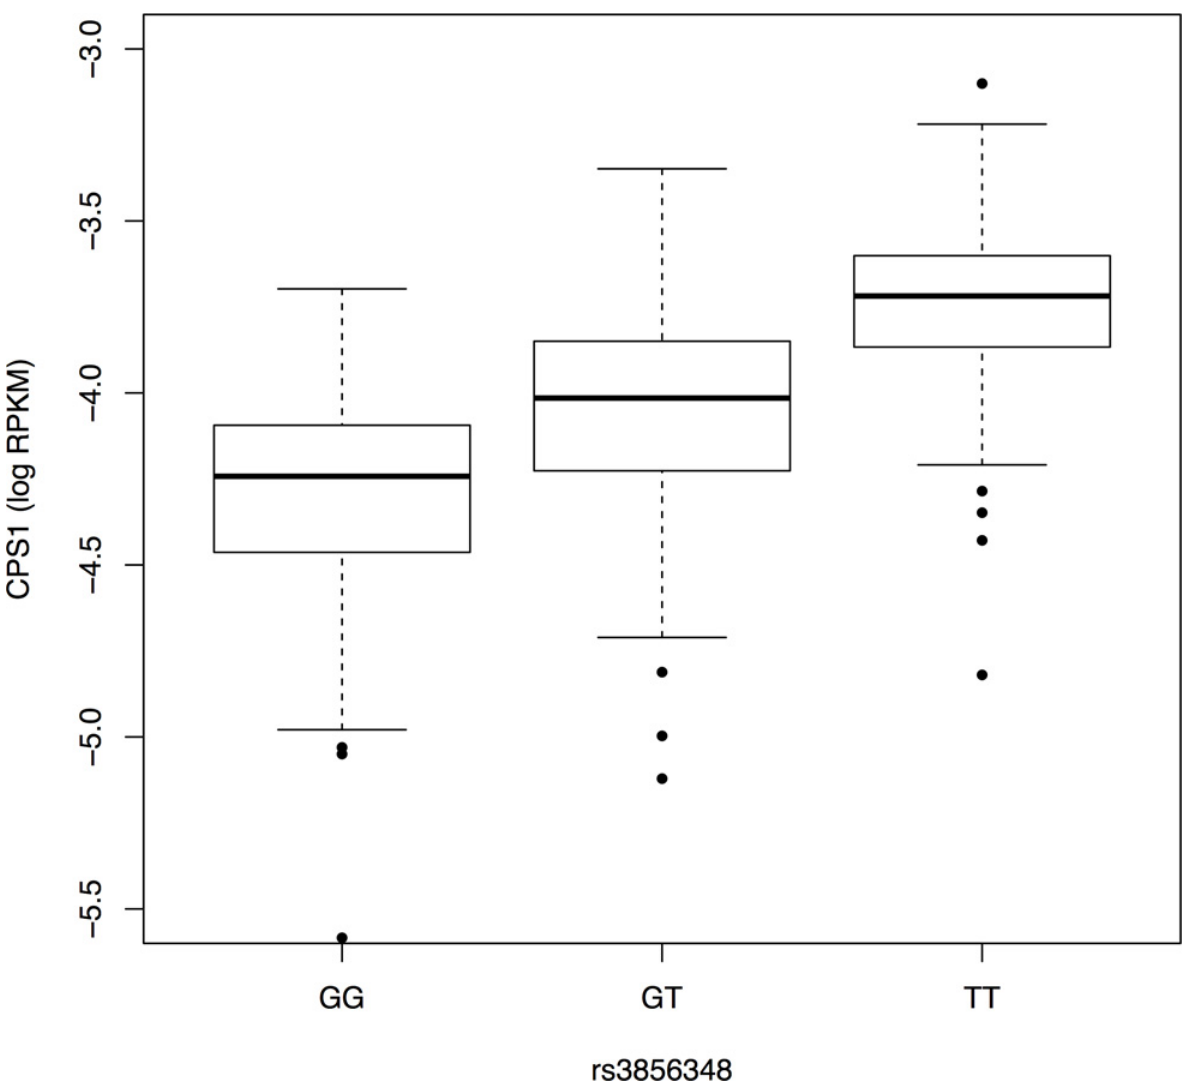
Fig 2. CPS1 and rs3856348. Correlation between genotypes at rs3856348, and CPS1 transcription